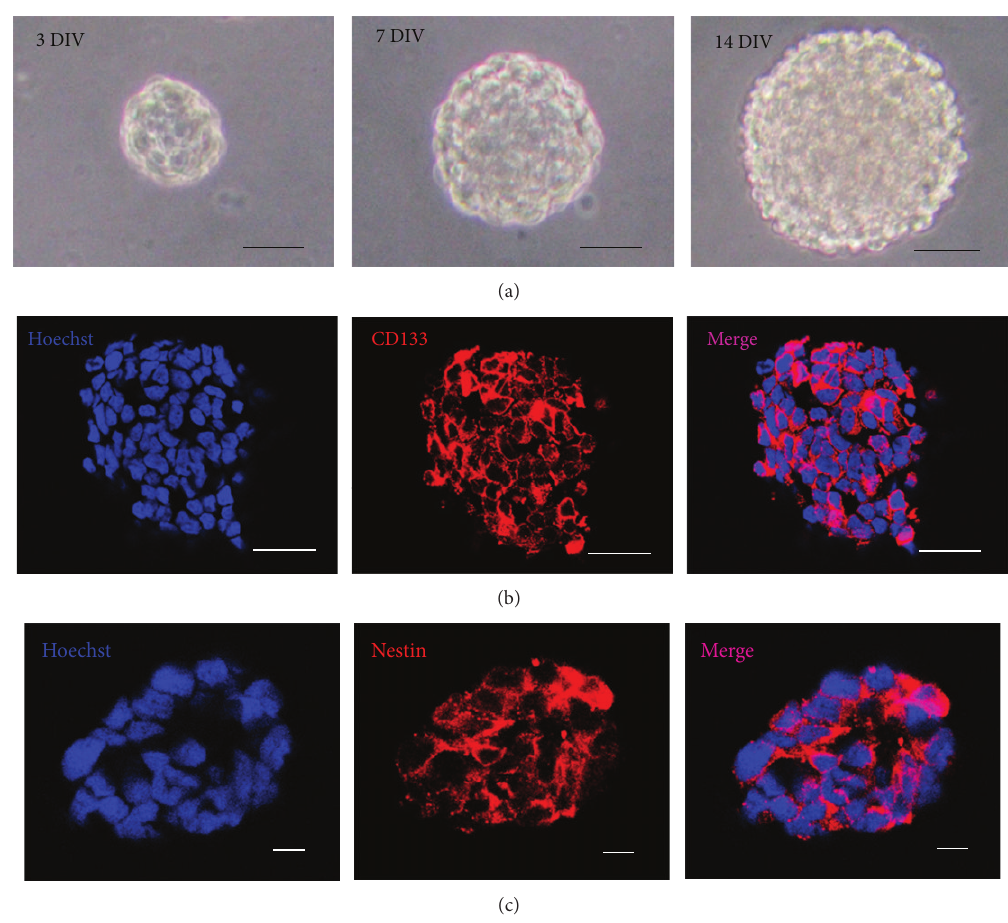
Figure 1: Characterization of GBSCs derived from fresh surgical specimens. (a) Micrograph of GBSCs neurosphere incubated for 3 days, 7 days, and 14 days in vitro (DIV). A single GBSC grown in a define medium can form a neurosphere. Scale bar = 50 𝜇 m. (b)-(c) The expression of brain tumor stem cell markers; CD133 and nestin in neurospheres were confirmed by immunofluorescence. Scale bar = 20 𝜇